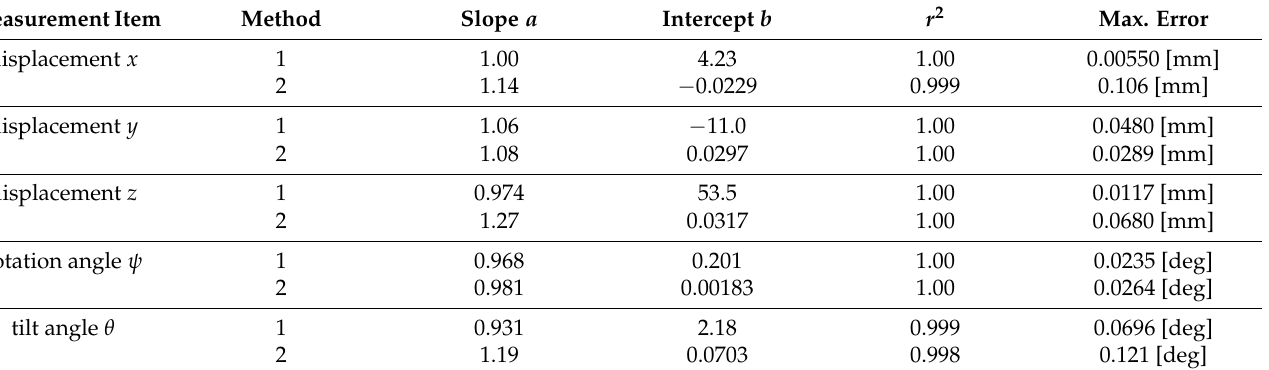
Table 1. Summary of experimental results: The x -, y -, z -direction, rotation angle ψ , and tilt angle θ were each varied by the optical stage, and a straight line y = ax + b was fitted to the value y estimated from the image by the proposed methods for the actual amount of change x . r 2 represents the coefficient of determination. In addition, Each straight line was used as a test line, and ˆ x = ( y − b ) / a was calculated from the estimated value y , then the absolute maximum value of | ˆ x − x | was calculated as the maximum absolute error